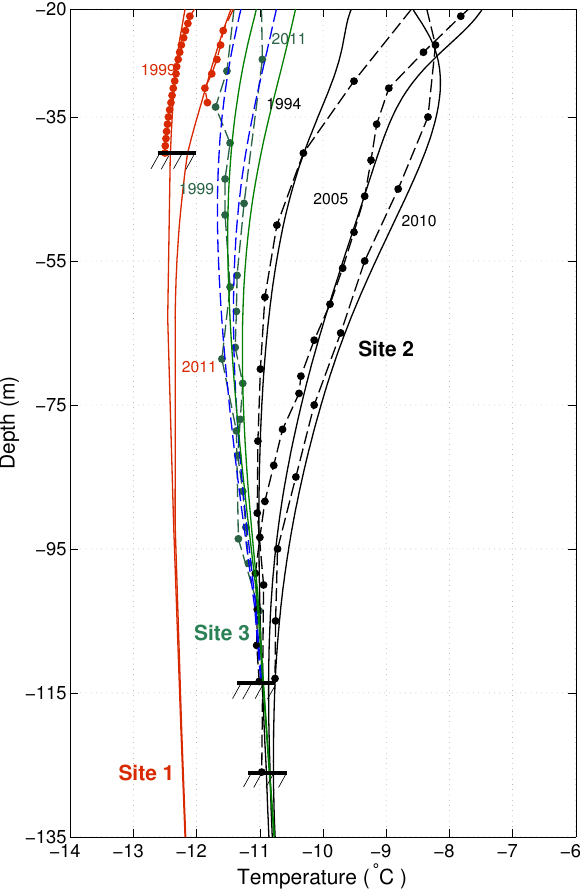
Fig. 11. Measured (dashed lines and dots) and modeled (solid lines) temperature profiles at the three drilling sites (site 1 = red, site 2 = black, site 3 = green) for different dates. The blue dashed line is the temperature profile modeled at site 3 in 1999 and 2012 for a melt factor set to 1.0 × 10 − 4 mw.e.d − 1 K − 1